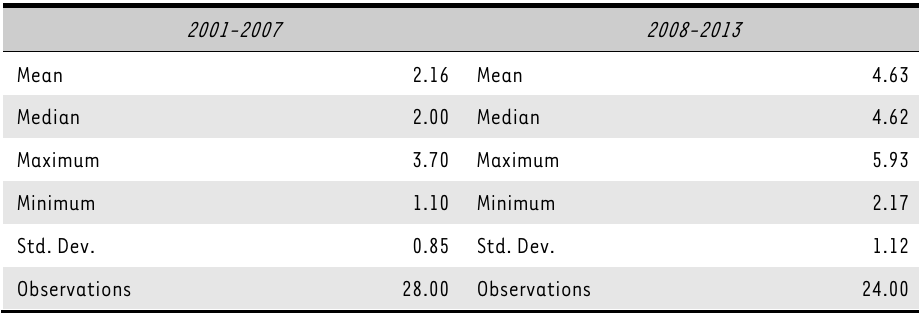
Descriptive analysis of the independent